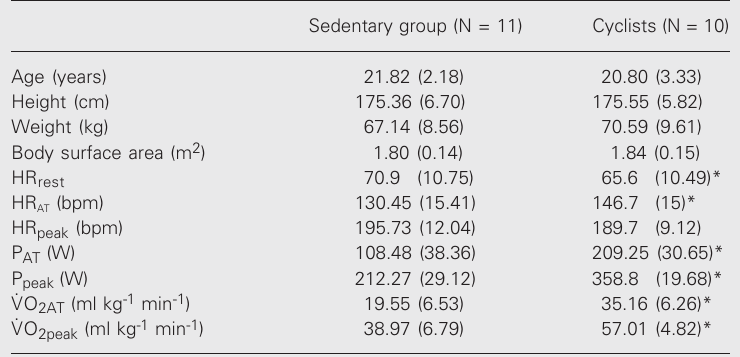
Table 1. Anthropometric and cardiorespiratory parameters of the sedentary and endur- ance-trained subjects at rest and during exercise.